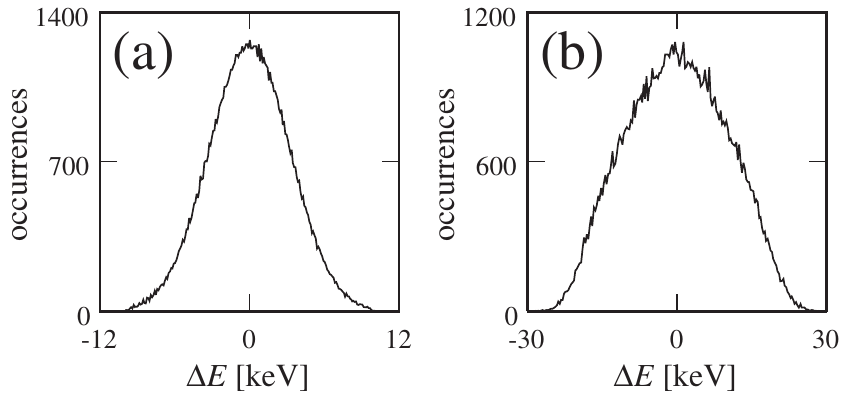
FIG. 11. (a) Gaussian energy distribution with rms energy spread of 3 keV. (b) Energy distribution when a 3-keV Gaussian distribution is heated by 10 keV in a laser heater matched to the beam’s transverse size.